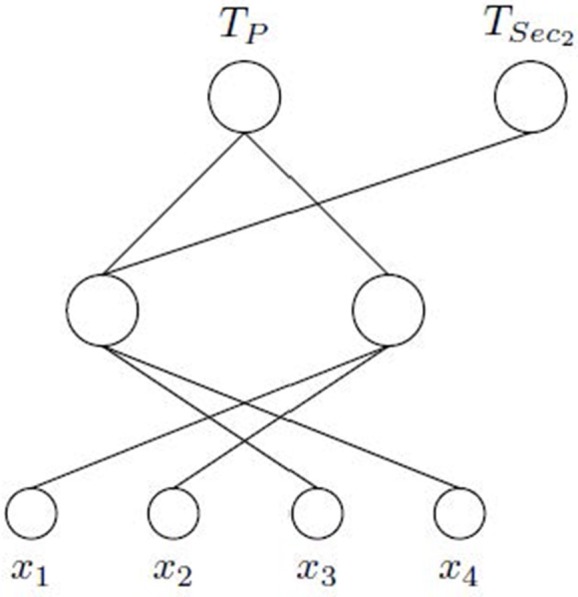
Logic Domain problem. Final architecture obtained with MTLASELM. TP shares a hidden layer neuron with TSec2, which learns the common part of both tasks.